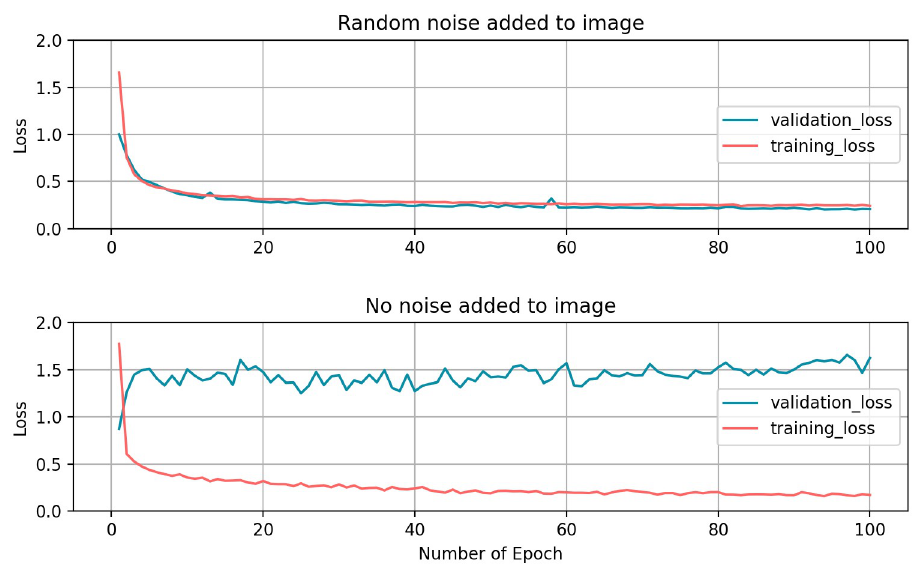
Fig 6. Effect of random noise added to automatically annotated training dataset. Comparison between learning curves of a neural network with and without random noise added to the training dataset. Validation and training loss curves are converging if random noise is added to the automatically annotated training dataset, as the filtered images are without background noise.